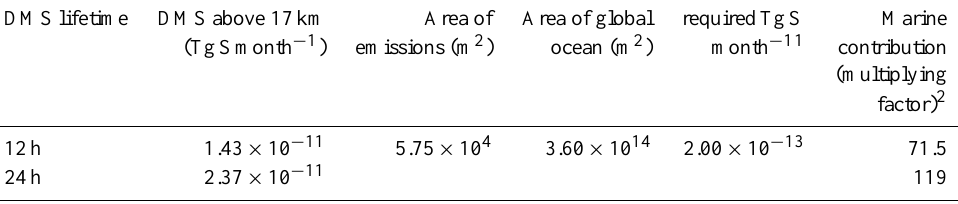
Table 1. Calculation of sulphur loading above the TTL relative to the 0.015TgSyr − 1 required globally to maintain Junge layer after 2002 (Hofmann et al., 2009). The last column indicates the amount of sulphur reaching the TTL from the cruise track source region relative to the required amount of sulphur source to explain the observed change in the Junge layer, scaled by the size of the cruise track source